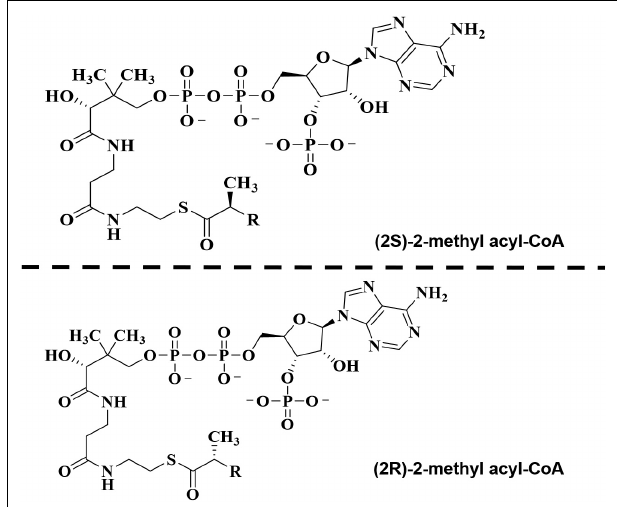
FIGURE 2 | Illustration for the oxidation step of (3R)- and (3S)-phytanic acid as resulting from normal diet and (25R)-trihydroxy cofluorocarbonate (THCA) biosynthesized from liver-derived